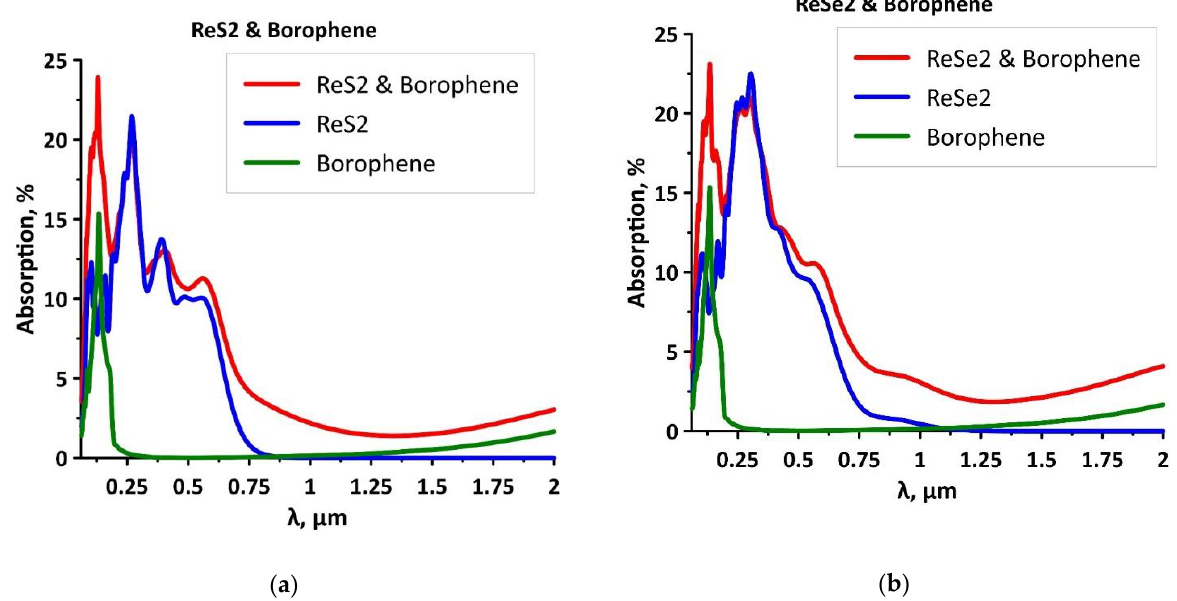
Figure 5. Optical absorption coefficient of borophene/ReS 2 ( a ) and borophene/ReSe 2 ( b ) van der Waals heterostructures.